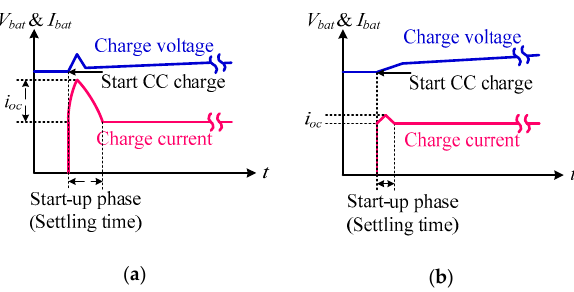
Figure 18. During start-up phase, different control technologies result in current overshoot occurrence. ( a ) Normal PI design. ( b ) Using the ZBFS method.